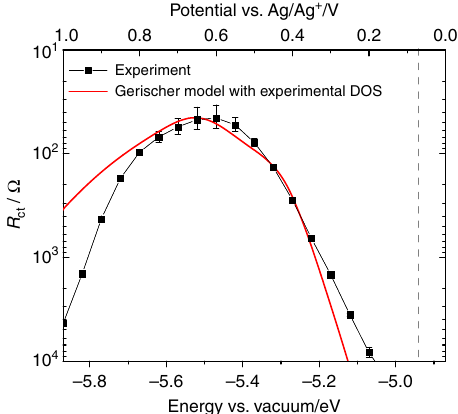
Fig. 3 Typical Nyquist plot of the impedance of e-P3HT in 1 mM FcDM solution at a bias voltage of 0.35 V. Labels indicate the angular frequencies ω at select points